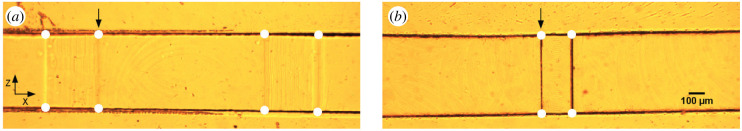
Microscopic images at the start of the experiment: (a) Casa’s flow chamber and (b) van Rooij’s flow chamber. The white points indicate the corners of the stenotic region. The black arrows point to the vertical line on which the alignment of the normalized pixel intensity was based.